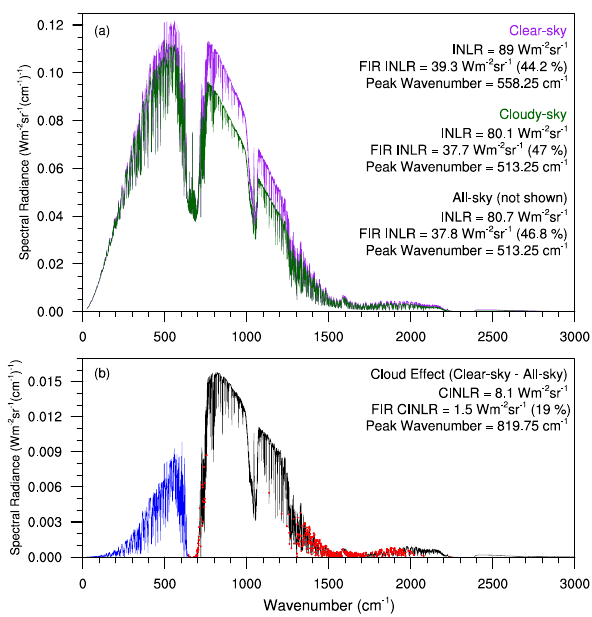
Figure 13. The outgoing long-wave spectral radiances constructed from IASI data globally averaged for (a) clear (purple) and cloudy (green) pixels. Numbers in brackets are the fractional FIR contri- butions to the total long-wave broadband INLR. The all-sky curve is between the clear and cloudy curves but is not plotted for clarity. (b) The difference between the clear-sky and all-sky spectrums con- structed from IASI measurements (black) and estimated far infrared radiance (blue) from predictor wavelengths in the mid-infrared with the highest correlations (red dots). The number in brackets is the fractional contribution of the FIR INLR (FIR CINLR) to the total INLR (CINLR). Data are the area weighted mean of April